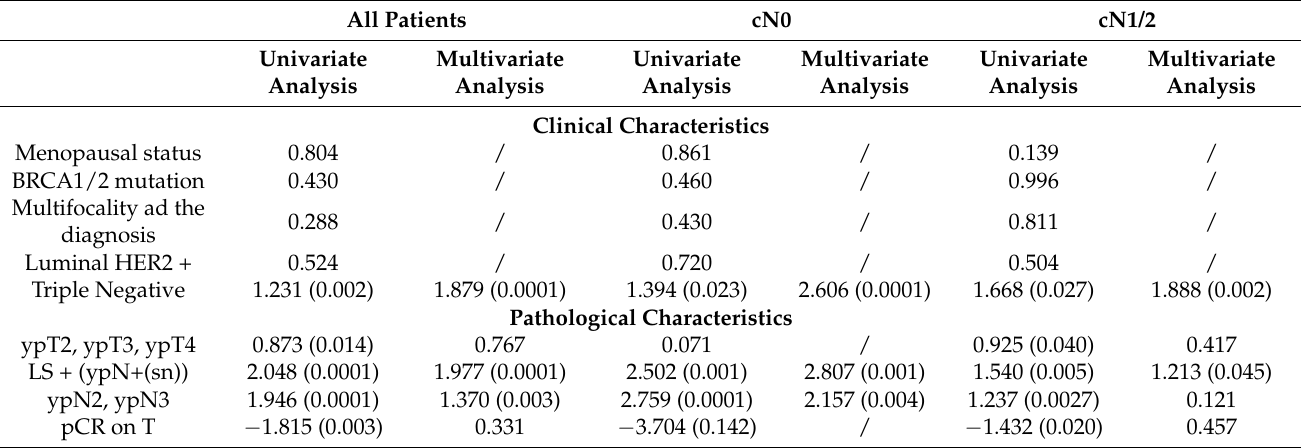
Table 5. Univariate and multivariate analysis for Distant Disease Free